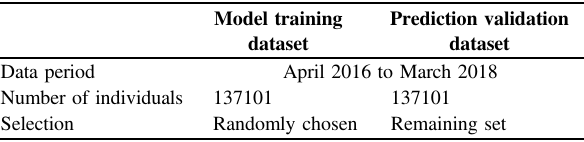
Table 3 Datasets for model training and prediction validation (for Tables 4 – 6).